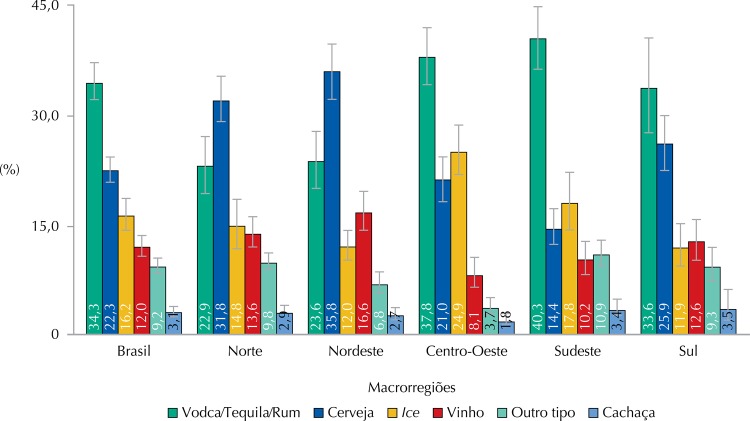
Tipos de bebidas alcoólicas consumidas pelos adolescentes por macrorregião. ERICA, Brasil, 2013-2014.